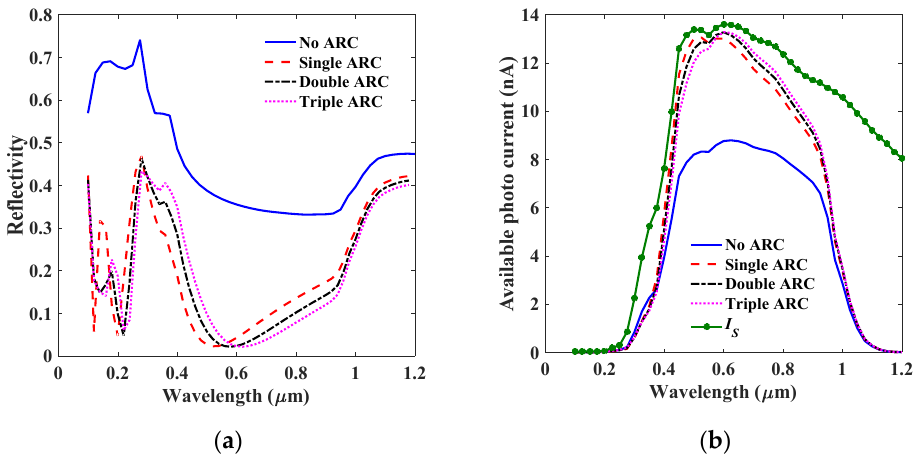
Figure 6. Comparison between different ARC methods applied to the proposed structure ( a ) reflec- tivity and ( b ) available and source photo currents.